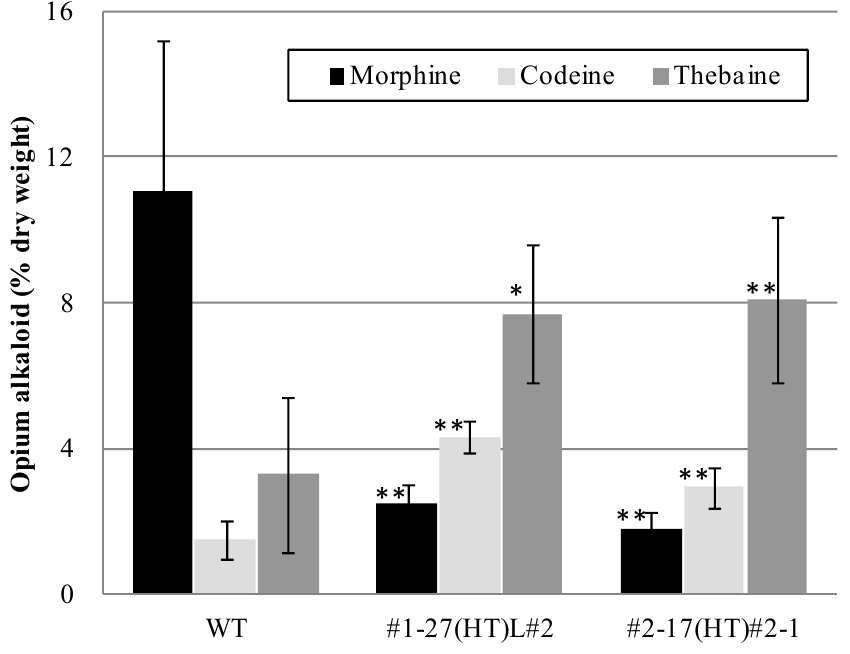
Figure 4. Morphine, codeine, and thebaine contents in T 10 [#1-27(HT)L#2], and 12 [#2-17(HT)#2-1] plants. Bars indicate standard deviation. * p < 0.005 and ** p < 0.001 vs. WT.